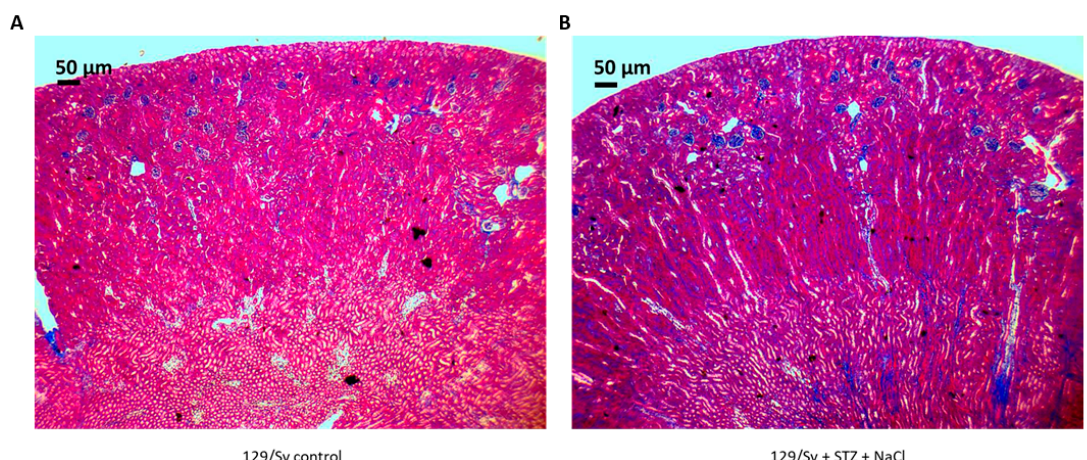
Figure 7. Streptocozocin (STZ) + NaCl-induced kidney disease in mice. Representative photomicrograph (4×) of Masson’s Trichrome-stained kidneys from a control 129/Sv mouse ( A ) and an STZ + NaCl-administered 129/Sv mouse ( B ). Acute tubular necrosis and renal interstitial scarring is clearly evident in the latter.